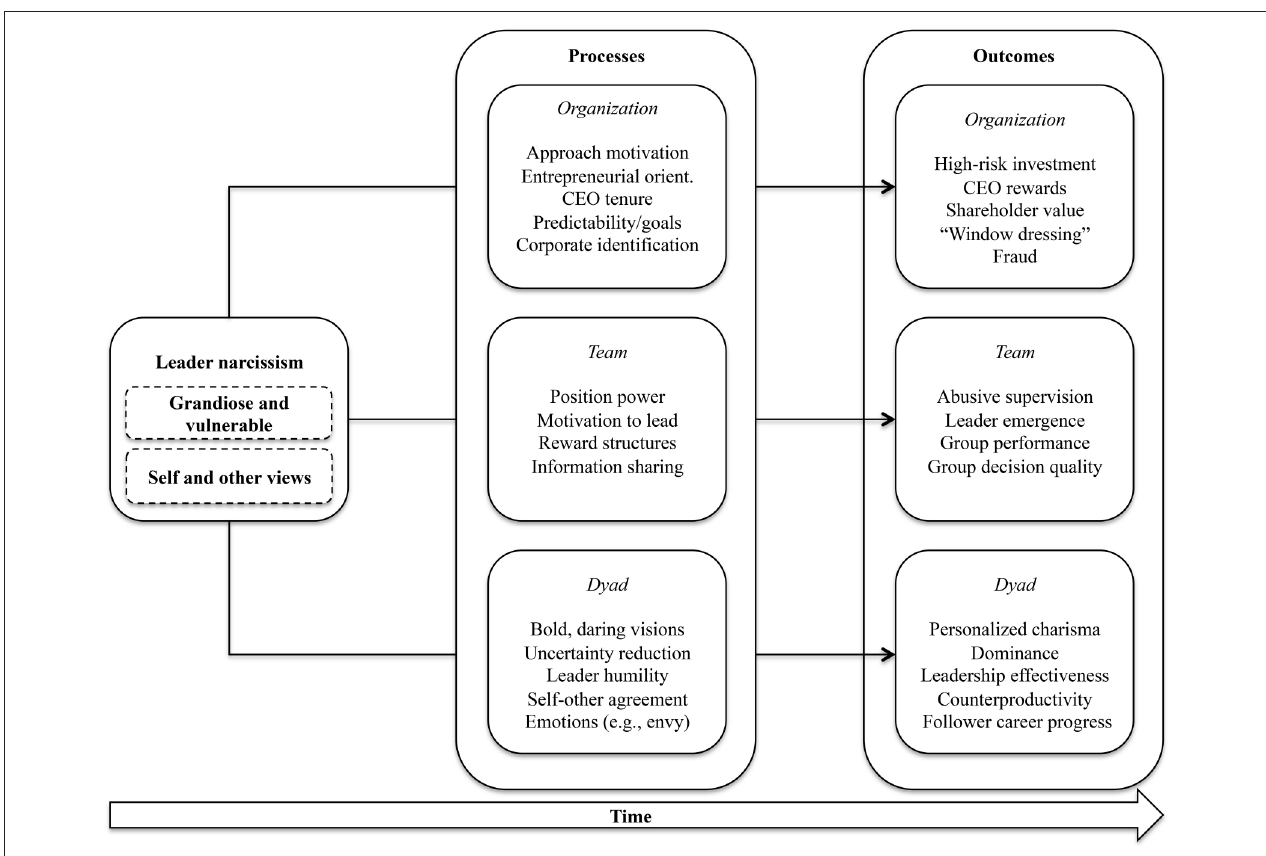
FIGURE 1 | Summary of